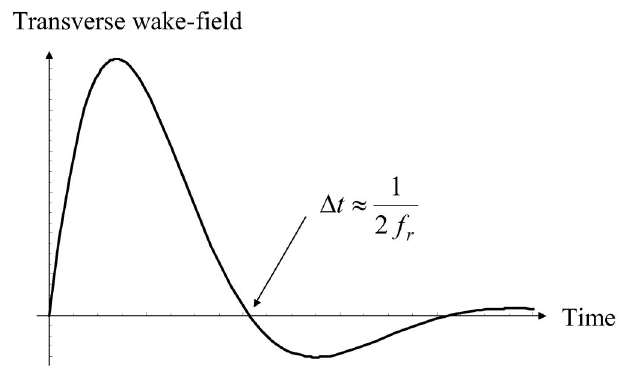
FIG. 57. Transverse Green-function wakefield for a classical broadband resonator as a function of time [84].